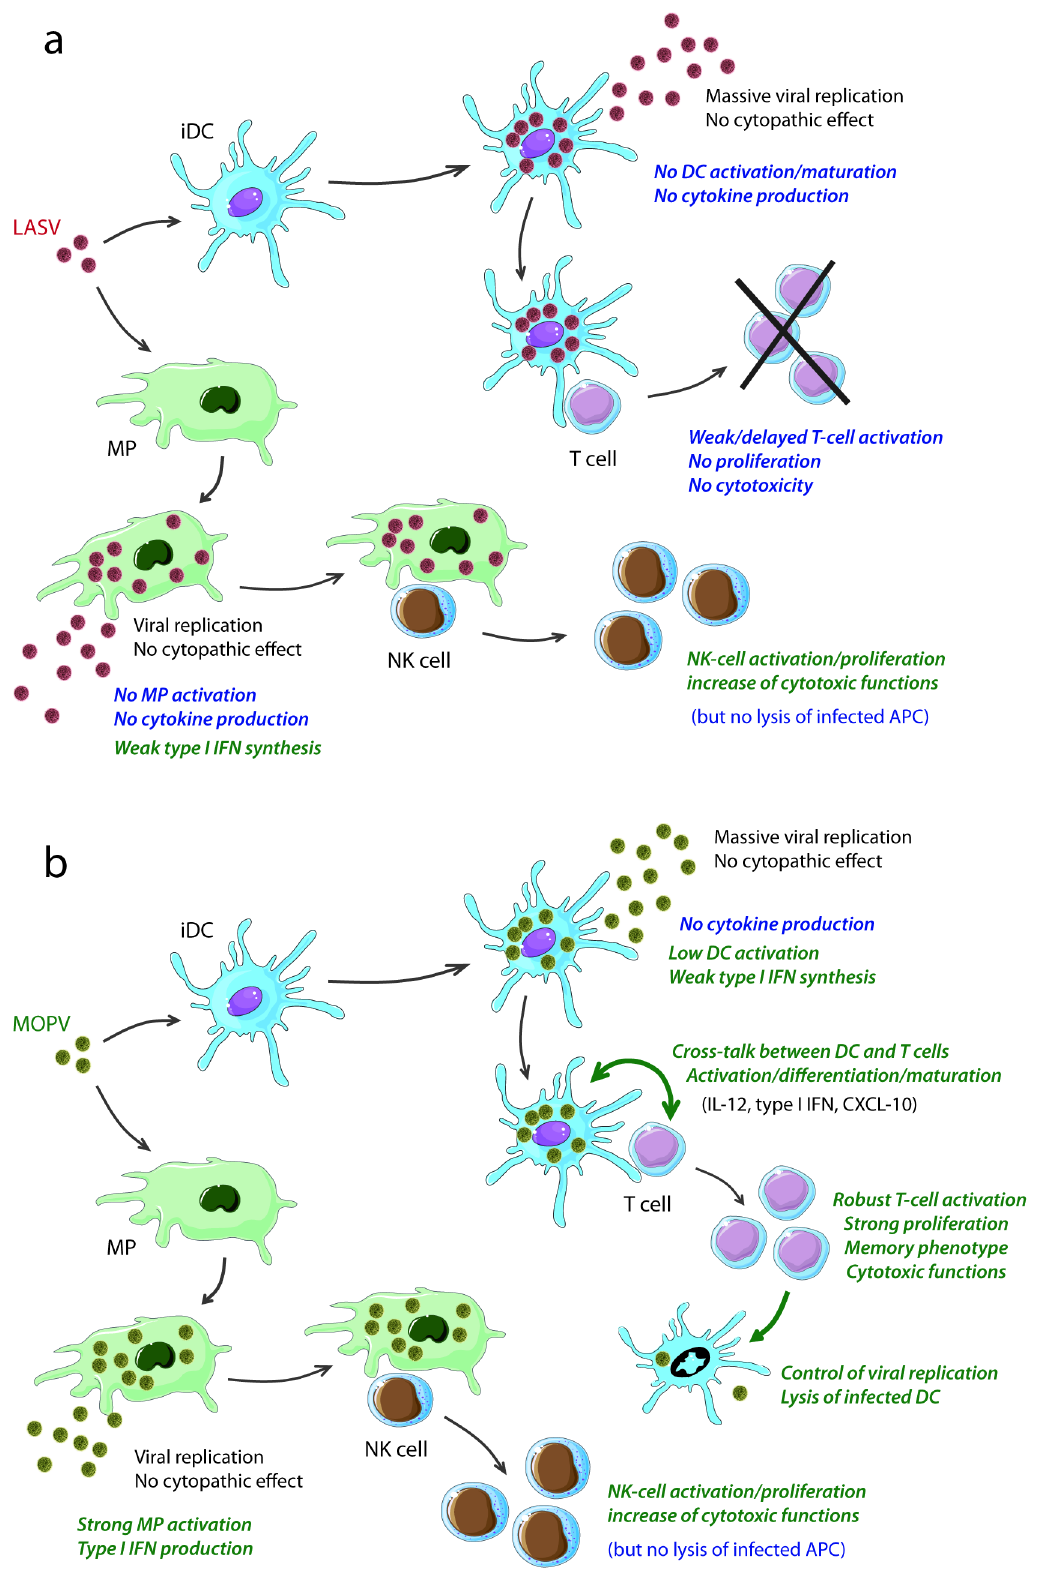
Figure 1. Comparison of the responses induced in vitro by LASV (a) and MOPV (b) in human cells (adapted from references